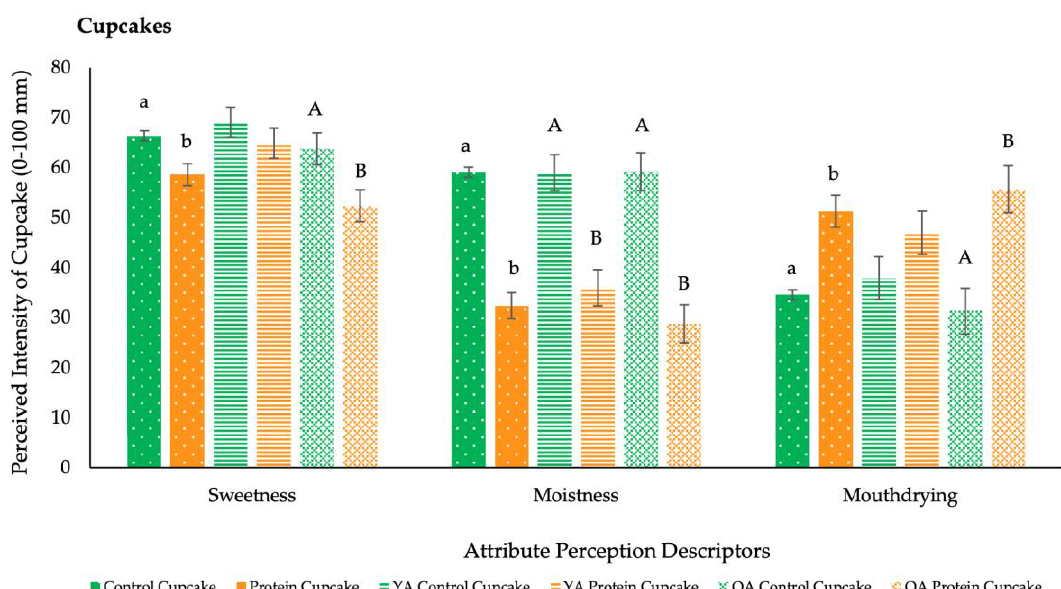
Figure 6. Volunteers attribute perception mean ratings of cupcakes by overall and age (main study: n = 70; VAS, 0–100 mm). Values are expressed as LSM estimates ± standard error from SAS output. Significant differences ( p < 0.05) between samples (by overall: control vs. protein, and age: younger adults (YA) vs. older adults (OA)) are denoted by differing small letters, and significant differences within age groups are denoted by differing capital letters; no letter reflects no significant difference.